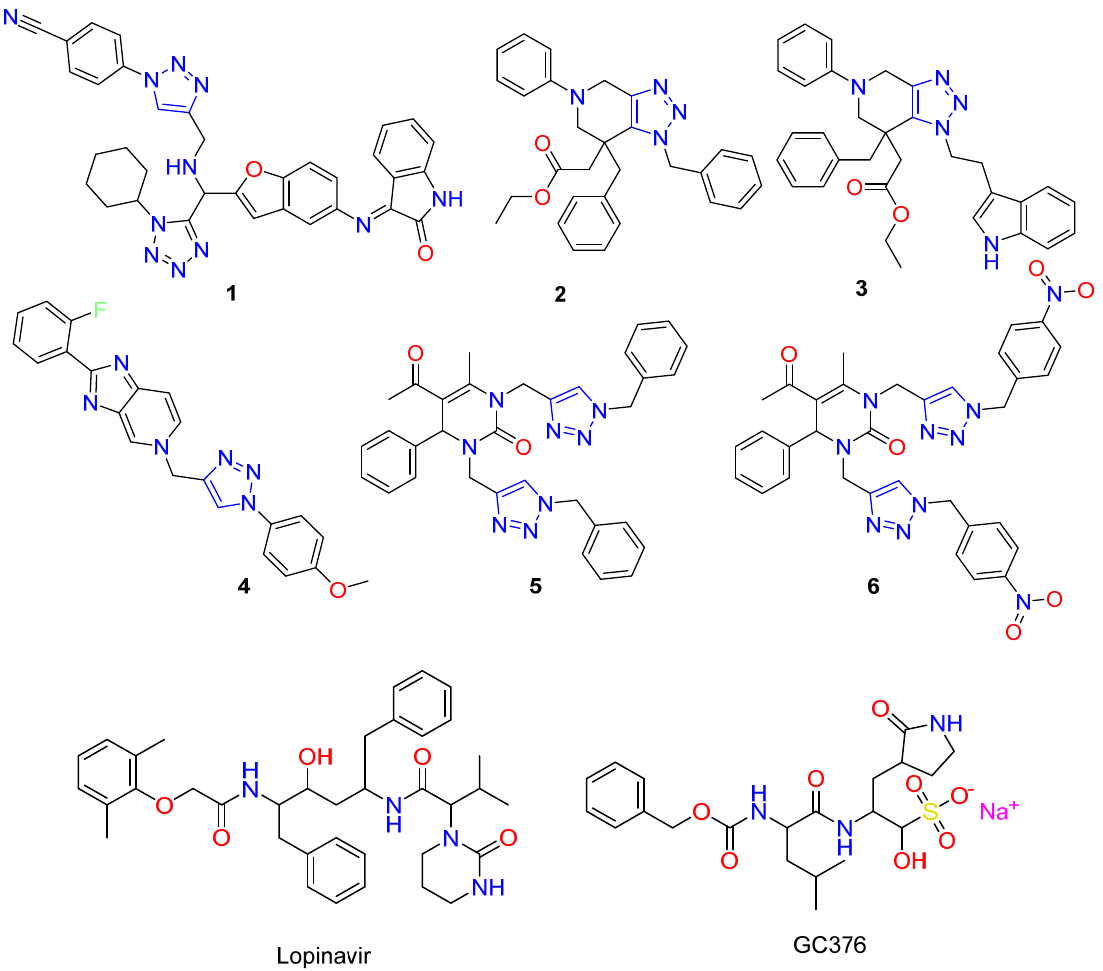
Figure 1. 1,2,3-Triazoles as a pharmacophoric fragment presented in potent antiviral molecules.